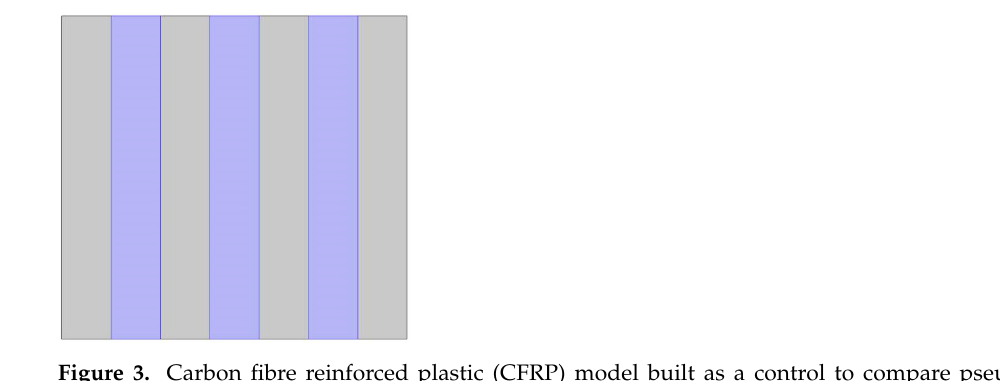
Figure 3. Carbon fibre reinforced plastic (CFRP) model built as a control to compare pseudo-composites against.